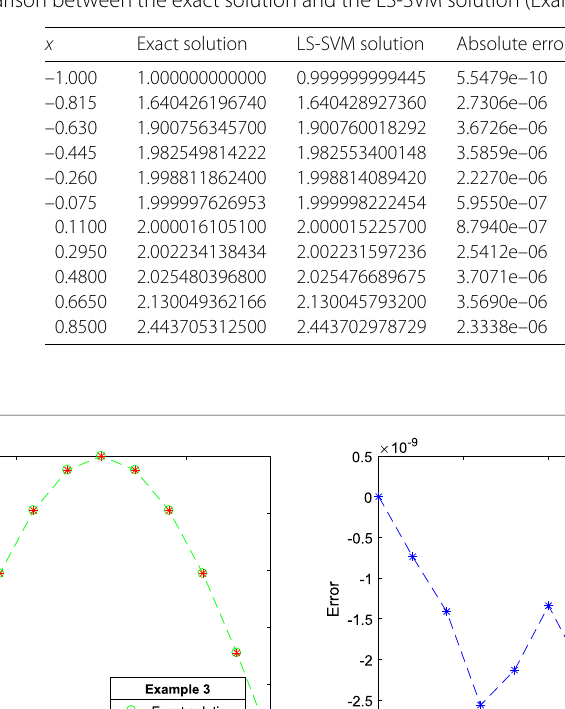
Table 2 Comparison between the exact solution and the LS-SVM solution (Example 2)